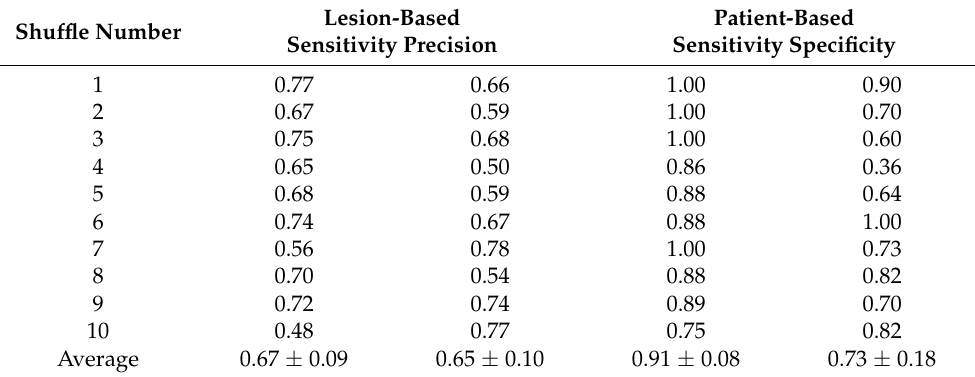
Table 3. The quantitative results of the Faster R-CNN. All 194 PC BS images were shuffled 10 times. One shuffle means one